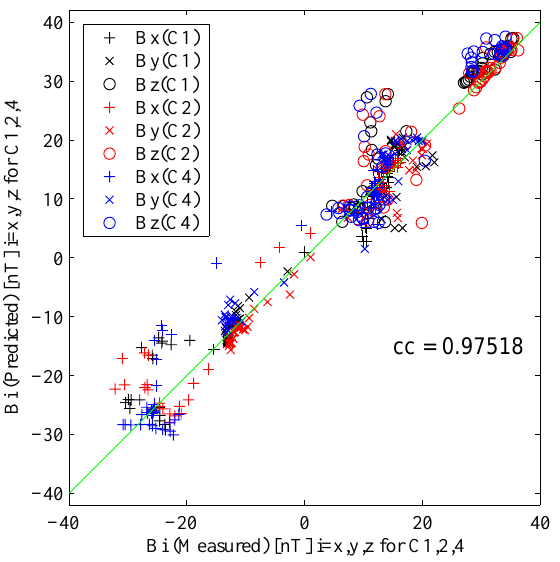
Fig. 13. Wal´en relation for the C3 magnetopause crossing oc- curring at 06:24 UT on 5 July 2001. V HT =( − 254.11, − 95.92, 225.78)km/s in GSE. The Wal´en slope close to +1 is consistent with a rotational discontinuity magnetopause, with the magnetic field having an inward component.